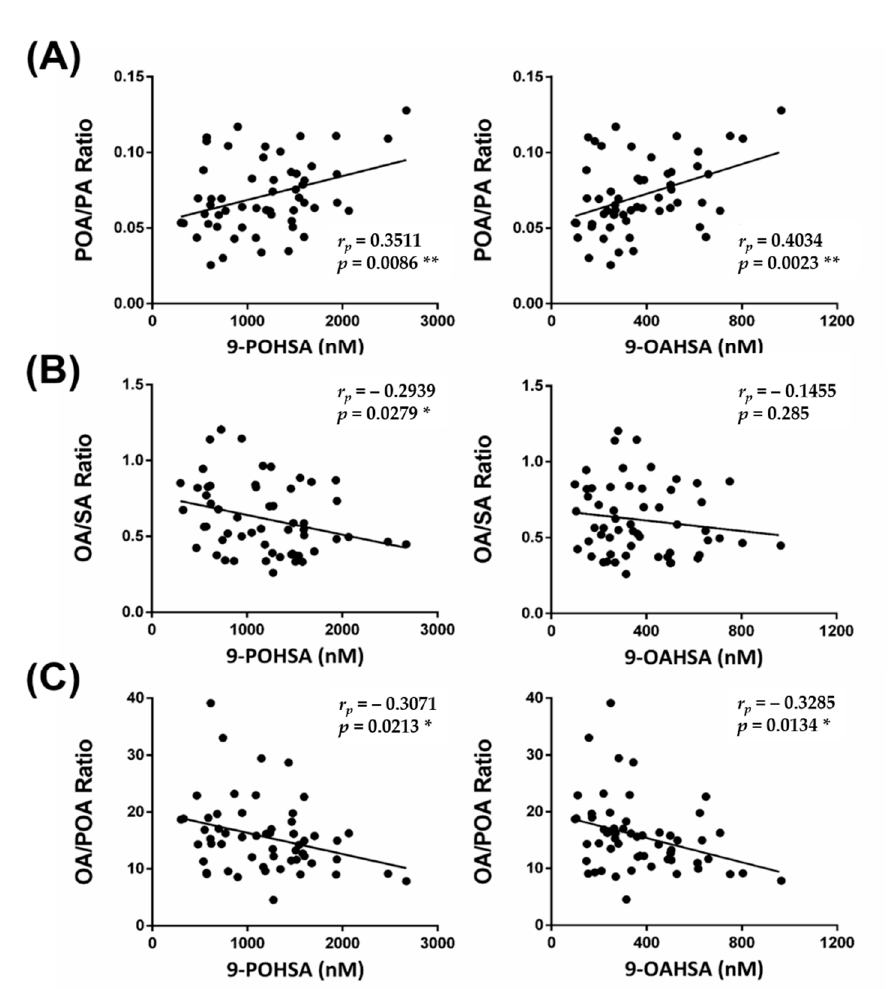
Figure 6. The correlation of FAHFAs with their fatty acid precursor ratio. The correlations between 9-POHSA and 9-OAHSA with POA/PA ratio, OA/SA ratio, and OA/POA ratio are shown in ( A – C ), respectively. r p : Pearson correlation coefficient. Data are presented as mean ± SD (* p < 0.05, ** p < 0.01).